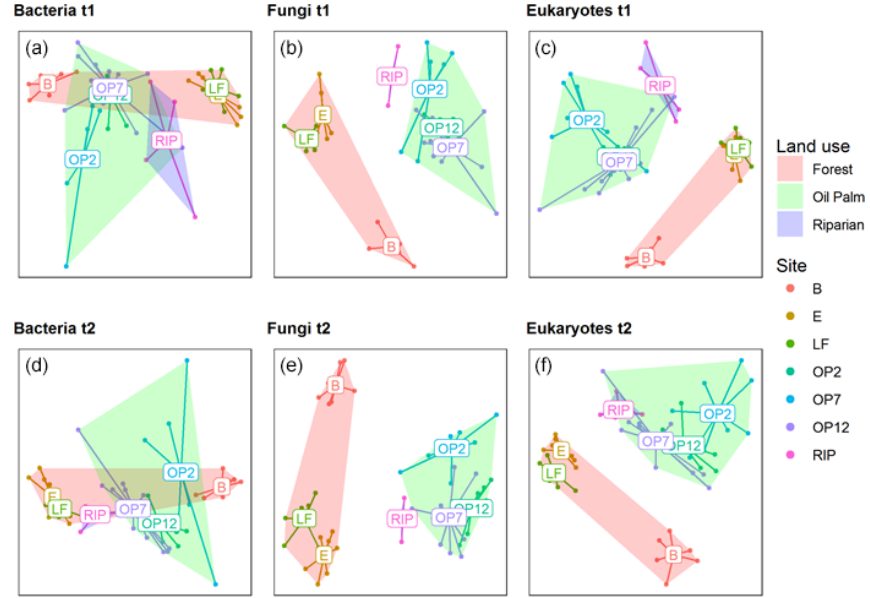
Figure 7. The 2D nonmetric multidimensional scaling ordination plots of bacteria, fungal, and eukaryotic communities from two sample dates in March 2016 ( a, b, c , t1) and November 2016 ( d, e, f , t2). Coloured points designate replicates from each site (B, E, LF: logged forests; OP2, OP7, OP12: oil palm plantations; RIP: riparian reserve), as indicated in the legend with additional site centroids denoted on the plots. In addition, hulls indicate broad land-use categories as indicated in the